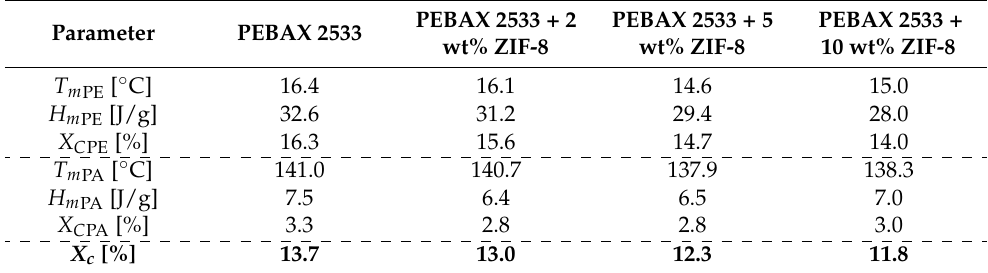
Figure 15. TGA analysis of membranes containing POSS-Ph in different concentrations. Table 1. DSC analysis results for membranes containing ZIF-8.